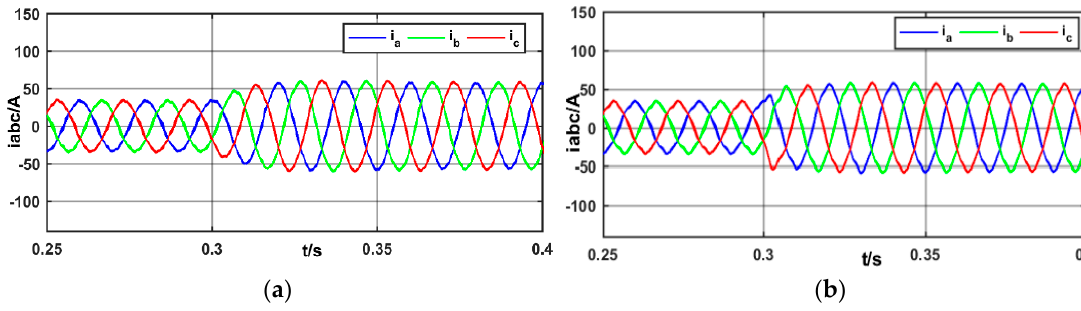
Figure 15. Three-phase grid currents during the load transients. ( a ) PI controller ( b ) SMADRC controller.